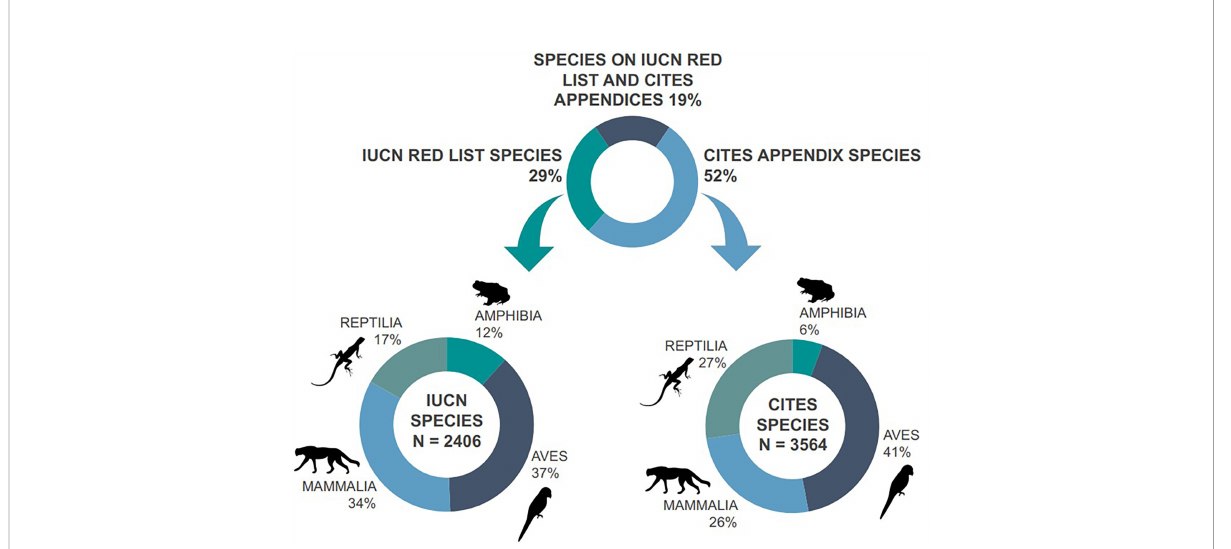
FIGURE 8 Top: The number of species listed on the IUCN Red List threat category ‘ Hunting and trapping terrestrial animals ’ N = 2406, the number of species listed on the IUCN Red List threat category ‘ Hunting and trapping terrestrial animals ’ that also appear listed on the CITES Appendices N = 953, and the number of species that are listed on the CITES Appendices that are not listed on the IUCN Red List threat category ‘ Hunting and trapping terrestrial animals ’ N = 2611 Bottom left: A breakdown of the percentage of species belonging to each taxonomic class (birds, mammals, amphibians, and reptiles) for the 2406 species listed on the IUCN Red List threat category ‘ Hunting and trapping terrestrial animals ’ Bottom right: A breakdown of the percentage of species belonging to each taxonomic class (birds, mammals, amphibians, and reptiles) for the 2611 species listed on the CITES Appendices that are not listed under the threat category ‘ Hunting and trapping terrestrial animals ’